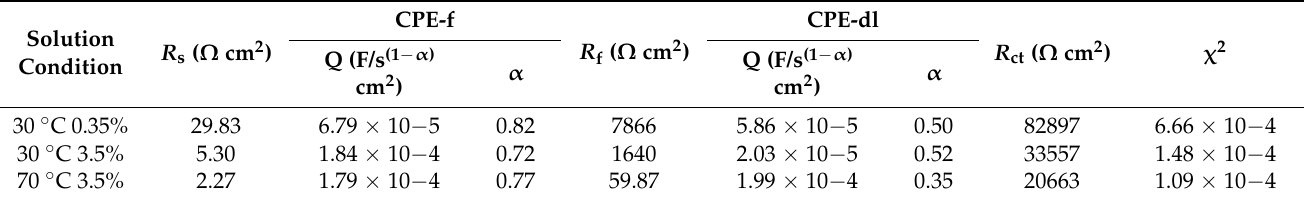
Figure 5. Relevant electrical circuit analogs used to simulate EIS spectra of Fe-based AMCs immersed in NaCl solution. Table 2. Electrochemical parameter obtained by fitting the EIS results for Fe-based AMCs samples in NaCl solution at various concentration and